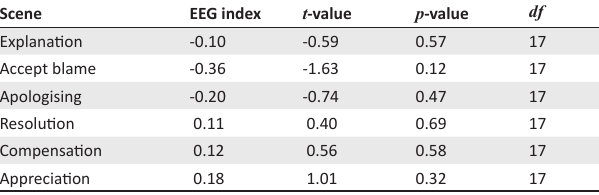
TABLE 6: Female respondents: More attractive male service